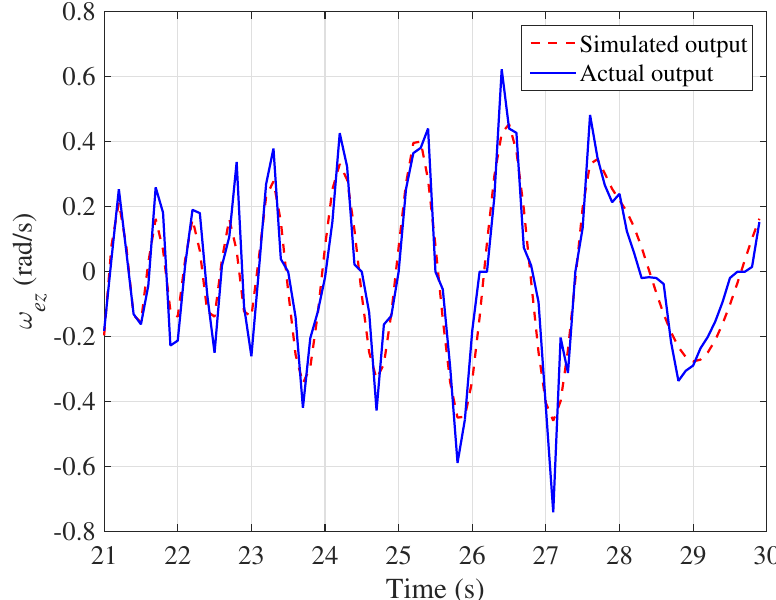
Figure 4. Model validation of azimuth axis.